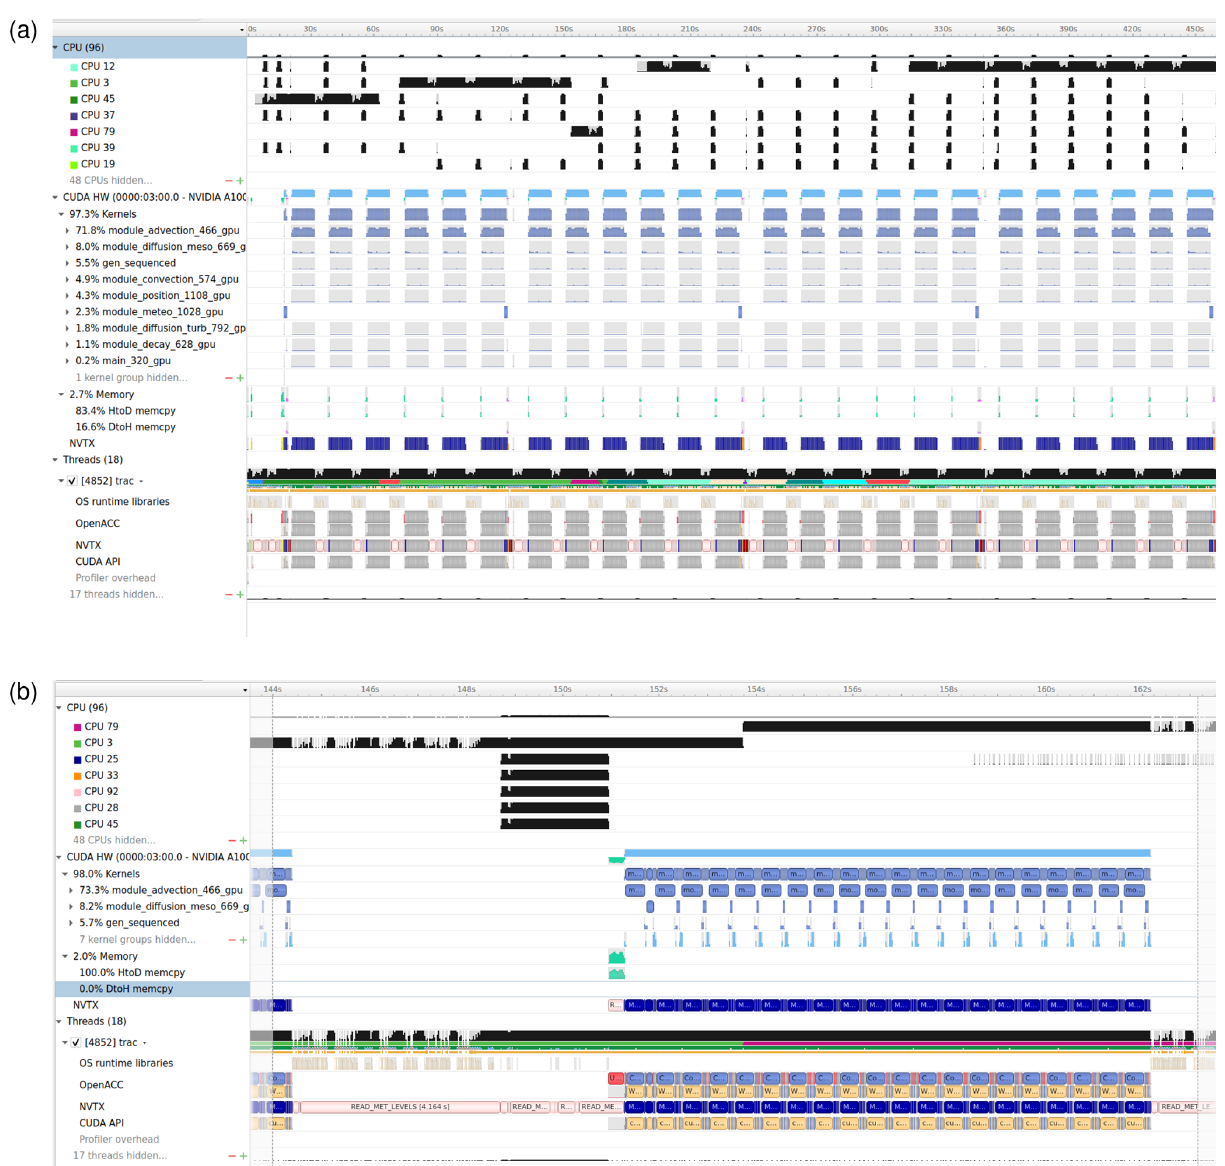
Figure 10. Timeline analysis of a 24h MPTRAC simulation comprising 10 8 particles driven by the ERA5 reanalysis for 1 January 2017. As an example, screenshots from the NVIDIA Nsight Systems performance analysis tool show the timeline for (a) the entire simulation and (b) a zoom for 1h simulation time (in between two time steps of the ERA5 input data). The performance data presented here are made available via an open data repository (Haghighi Mood and Hoffmann, 2022). See text for